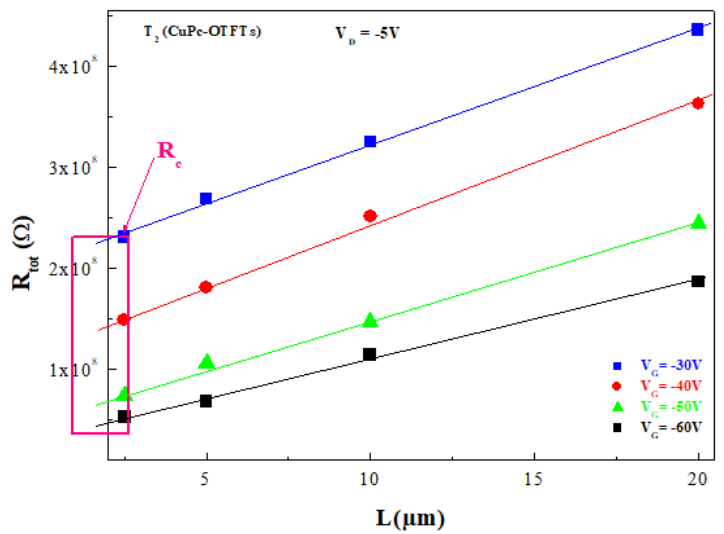
Figure 5. Total resistance as a function of channel length of the T 2 (CuPc-TFTs) for different high negative gate voltages. Illustration of the process of extraction of the R c using TLM.